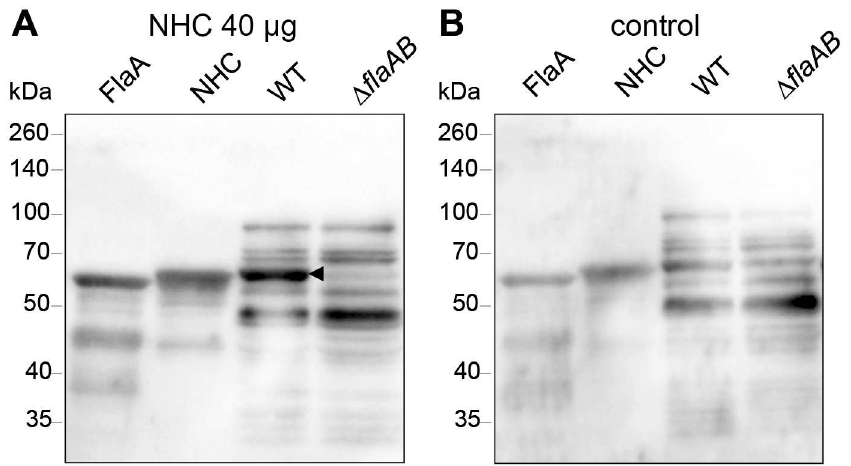
Fig 5. Western blot analysis of chicken sera. Purified flagellins(FlaA, NHC) and whole cell lysates of C . jejuni 81116 (wild type and Δ flaAB ) were analyzedby Western blotting. Pooled sera collected from 18 day- old chickens injected with ( A ) NHC flagellin (40 μ g) or ( B ) solvent were used as probes and detected with anti-chicken IgY antibody. Molecular mass is indicatedin kilodaltons(kDa). The arrowhead indicates the reactivity of the sera with the native C . jejuni FlaA flagellinthat is absent in the Δ flaAB mutant